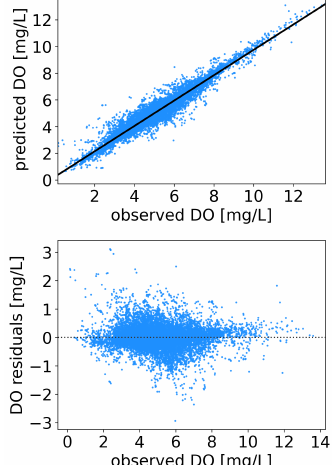
Figure 8. Nearshore model relational plot for Support Vector Regression ( top ) with R 2 = 0.945, along with the residuals plot ( bottom